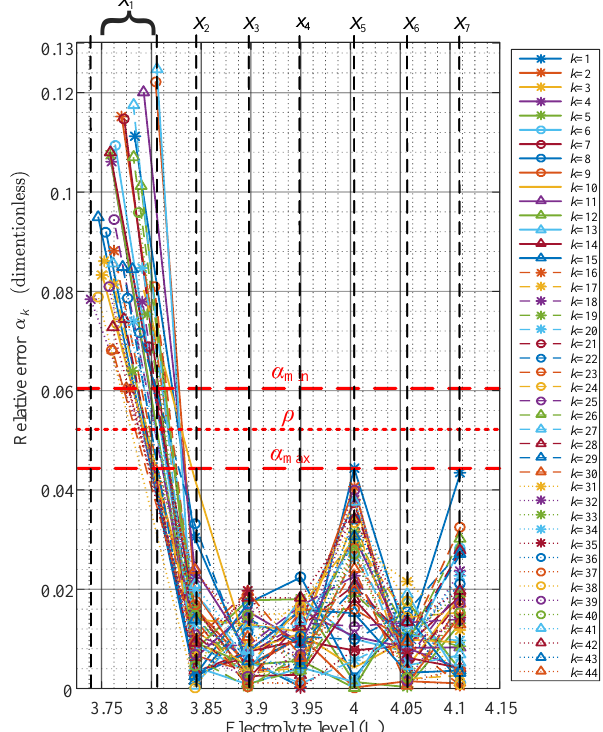
Figure 7. Evolution of the relative error α k ( x q ) for the eight electrolyte levels set